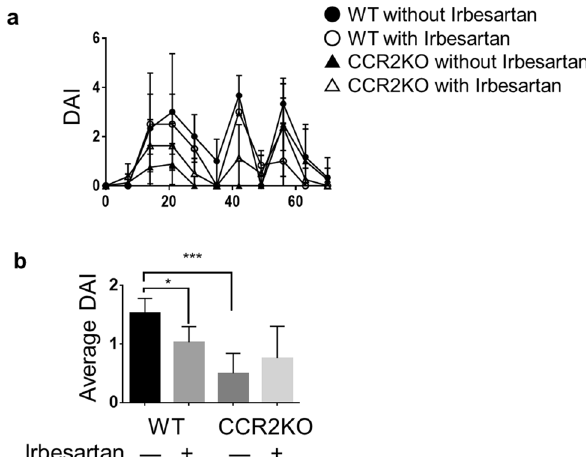
Figure 5. The monocyte chemoattractant protein-1 (MCP-1)/C–C chemokine receptor 2 (CCR2) pathway is the target of irbesartan on colitis-associated colon tumourigenesis. ( a ) The disease activity index (DAI) scores in azoxymethane/dextran sodium sulphate (AOM/DSS)-treated wild-type (WT) and CCR2-deficient mice receiving irbesartan or not were measured three times per week. ( b ) The histograms show average DAI scores obtained during the experimental period. Results were from two independent experiments with eight mice per group (pooled data). The experiments were performed three times and yielded similar results. Data are presented as mean ± SD. *P < 0.05 and ***P < 0.001.